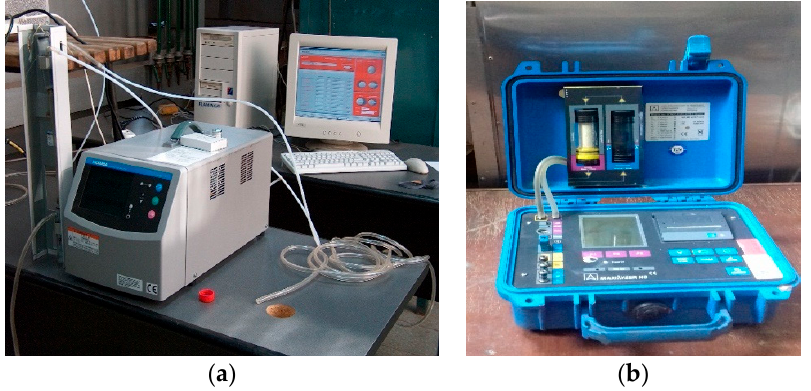
Figure 10. Measuring devices: ( a ) gas analyzer and data acquisition system; ( b ) exhaust gases analyzer.